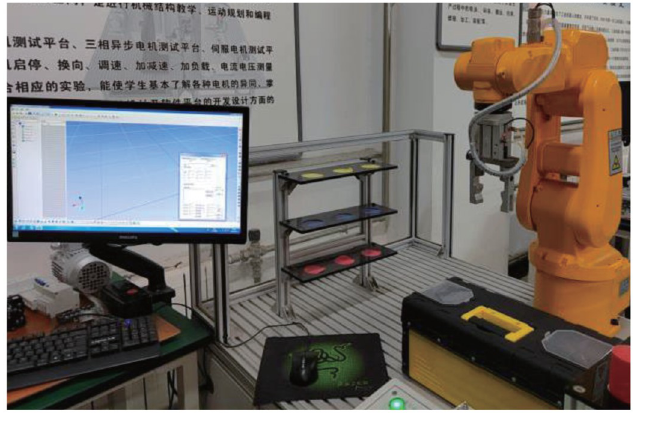
Fig 11. Servo system.